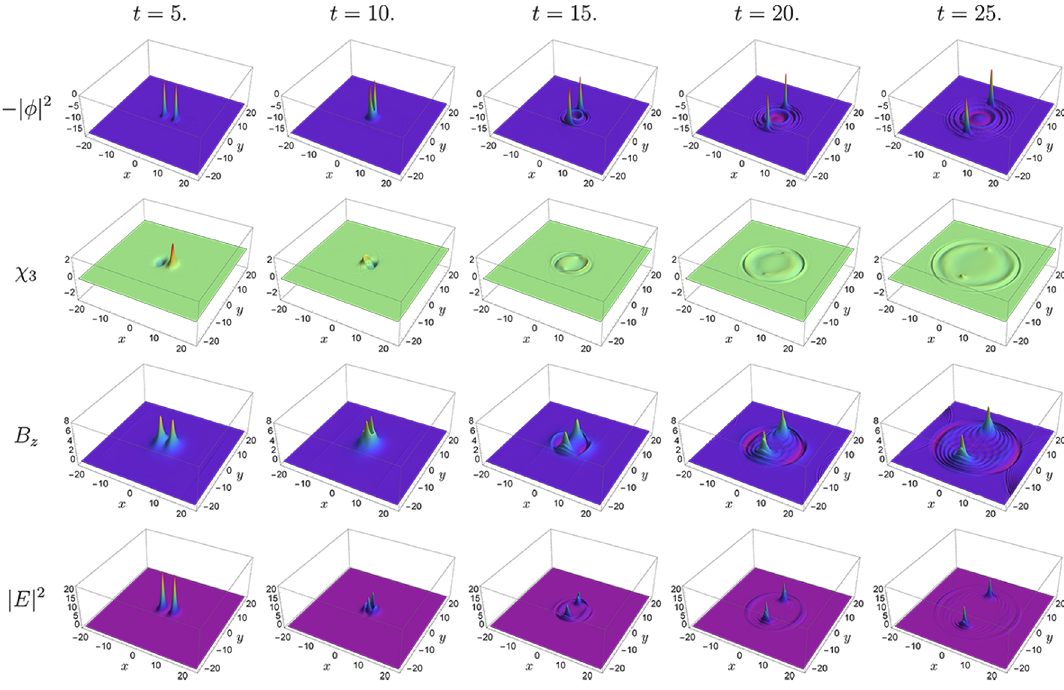
Figure 25 . Snapshots of −| φ | 2 , χ 3 , B z and | E | 2 for the head-on scattering of type II anti-parallel vortices with the initial velocity u = 0 . 8